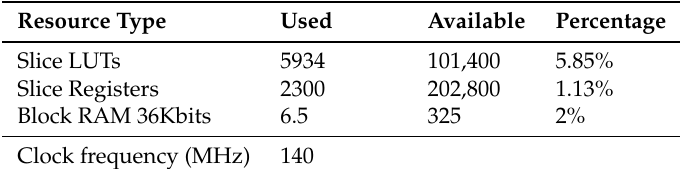
Table 8. FPGA resource utilization of the proposed perceptual encoder